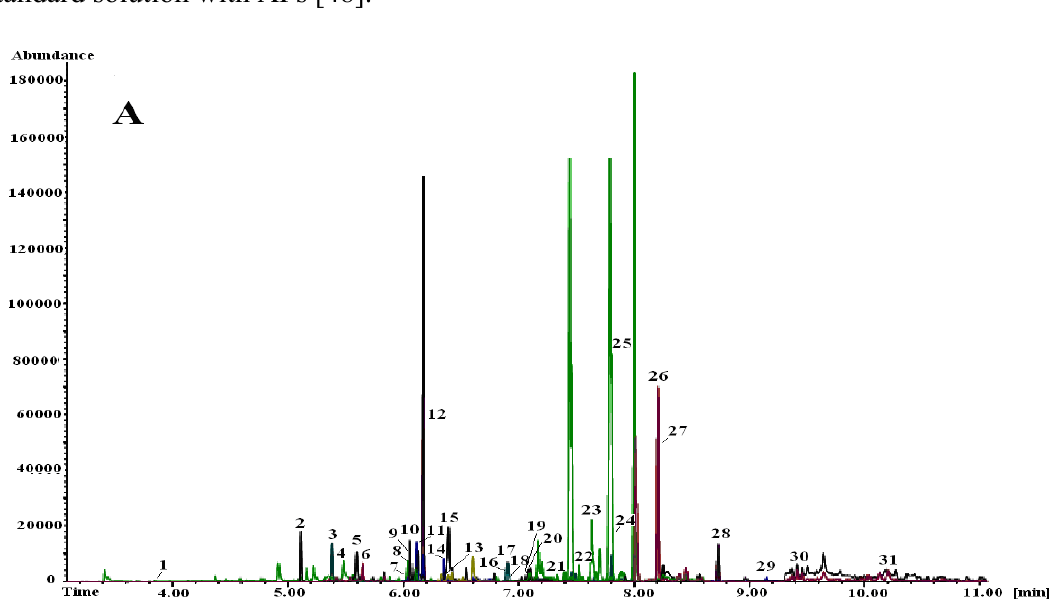
Figure 2. Chromatograms of target ions of 29 endocrine disrupting pesticides on the narrow-bore column CP-Sil 5 CB, 15 m × 0.15 mm I.D. × 0.15 µm connected to non-polar deactivated precolumn (1 m × 0.32 mm I.D.) in various standard solutions (50 ng